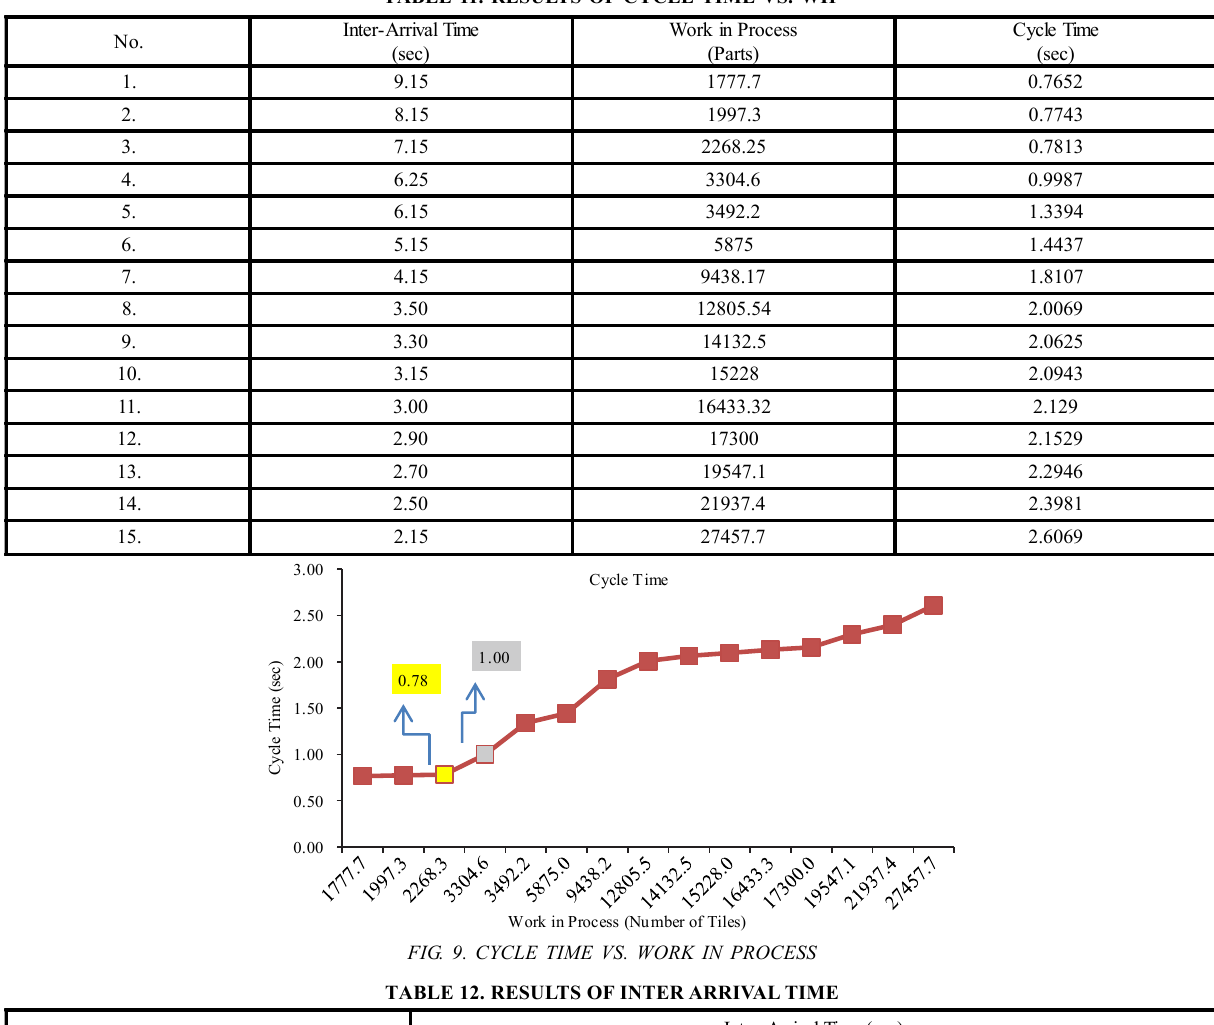
TABLE 11. RESULTS OF CYCLE TIME VS. WIP